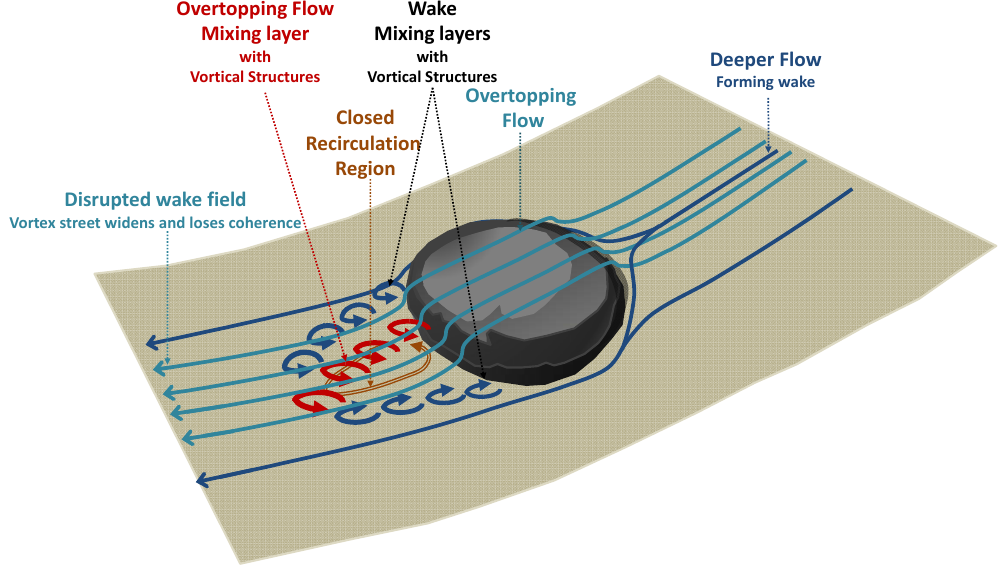
Fig. 7. Schematic of the flow field for a submerged isolated in-channel